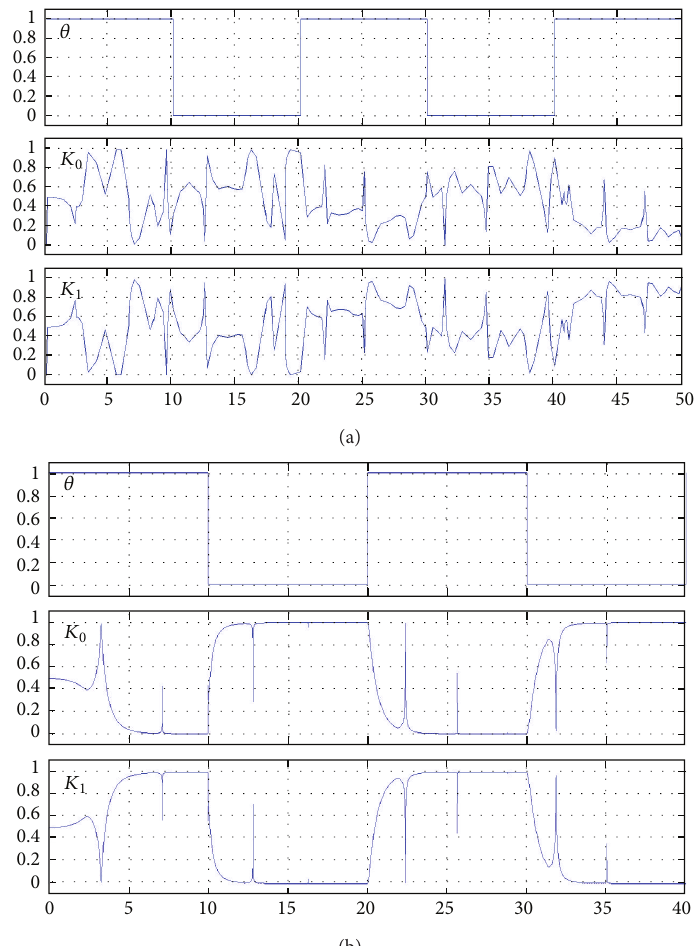
Figure 6: Time diagrams for alternating fault and confidence coefficients of technical states of a torpedo for (a) independent and (b) interacting